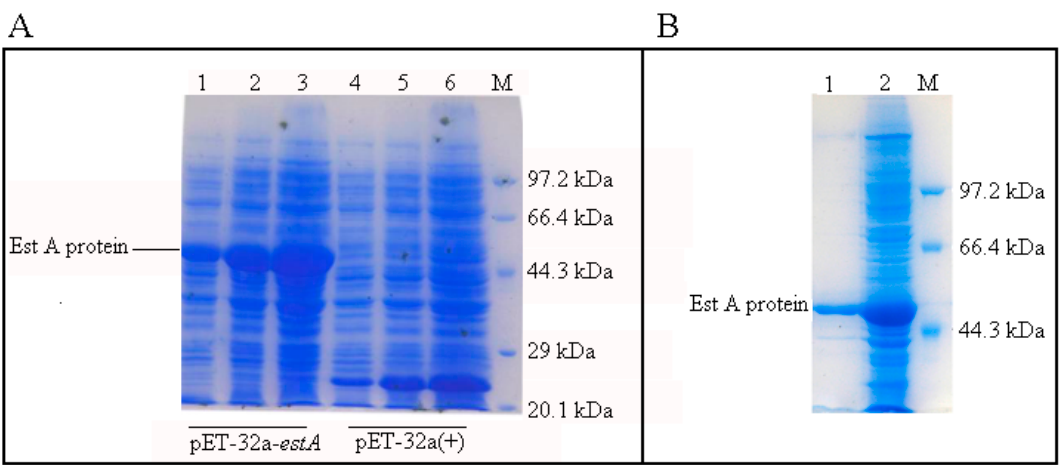
Figure 4. SDS-PAGE analysis of induced protein and its purification protein. ( A ) SDS-PAGE analysis of induced EstA protein at different temperatures. M = protein marker (Code No.: 3450, Takara, Dalian, China); lane 1, 2, and 3 = the full cell protein of Escherichia coli BL21/pET-32a- estA induced in 30 ◦ C, 25 ◦ C, and 20 ◦ C; lane 4, 5, and 6 = the full cell protein of Escherichia coli BL21/pET-32a (+) induced in 30 ◦ C, 25 ◦ C, and 20 ◦ C; ( B ) M = protein marker; lane 1 = purified EstA; lane 2 = the full cell protein of Escherichia coli BL21/pET-32a- estA expressed at 20 ◦ C.